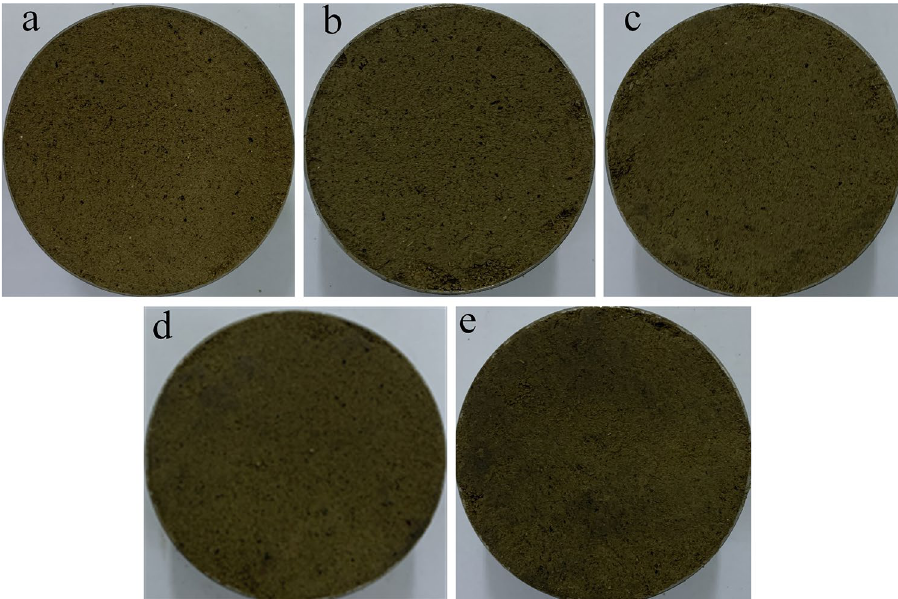
Figure 4. Soil samples affected by a single factor after 20 freeze–thaw cycles. ( a ) N = 20, 13%, 1.48 g cm −3 (F1), ( b ) N = 20, 16%, 1.48 g cm −3 (F4), ( c ) N = 20, 19%, 1.48 g cm −3 (F7), ( d ) N = 20, 13%, 1.53 g cm −3 (F2) and ( e ) N = 20, 13%, 1.58 g cm −3 (F3).